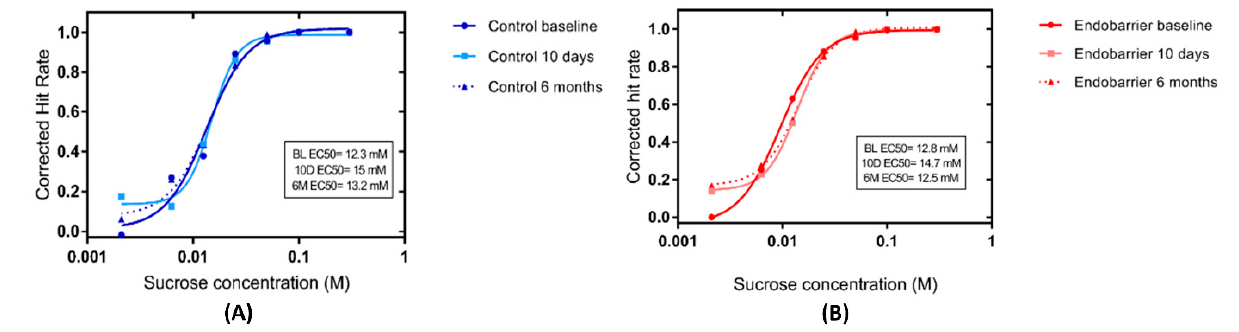
Figure 3. Sweet taste detection. Curves of the mean corrected hit rate over time for ( A ) controls (blue) n = 16 and (B) Endobarrier (red) n = 25 groups as a function of sucrose concentration. The EC50 was derived from the c-parameter in the curve fit and represented the concentration at which the corrected hit rate reaches 50% of the maximum asymptote.